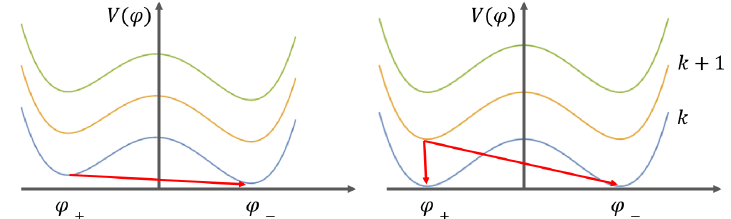
Figure 1. The effect of the interaction among universe with a Coleman-DeLucia potential ( left ) and with a quartic potential ( right ). Ref. [9]